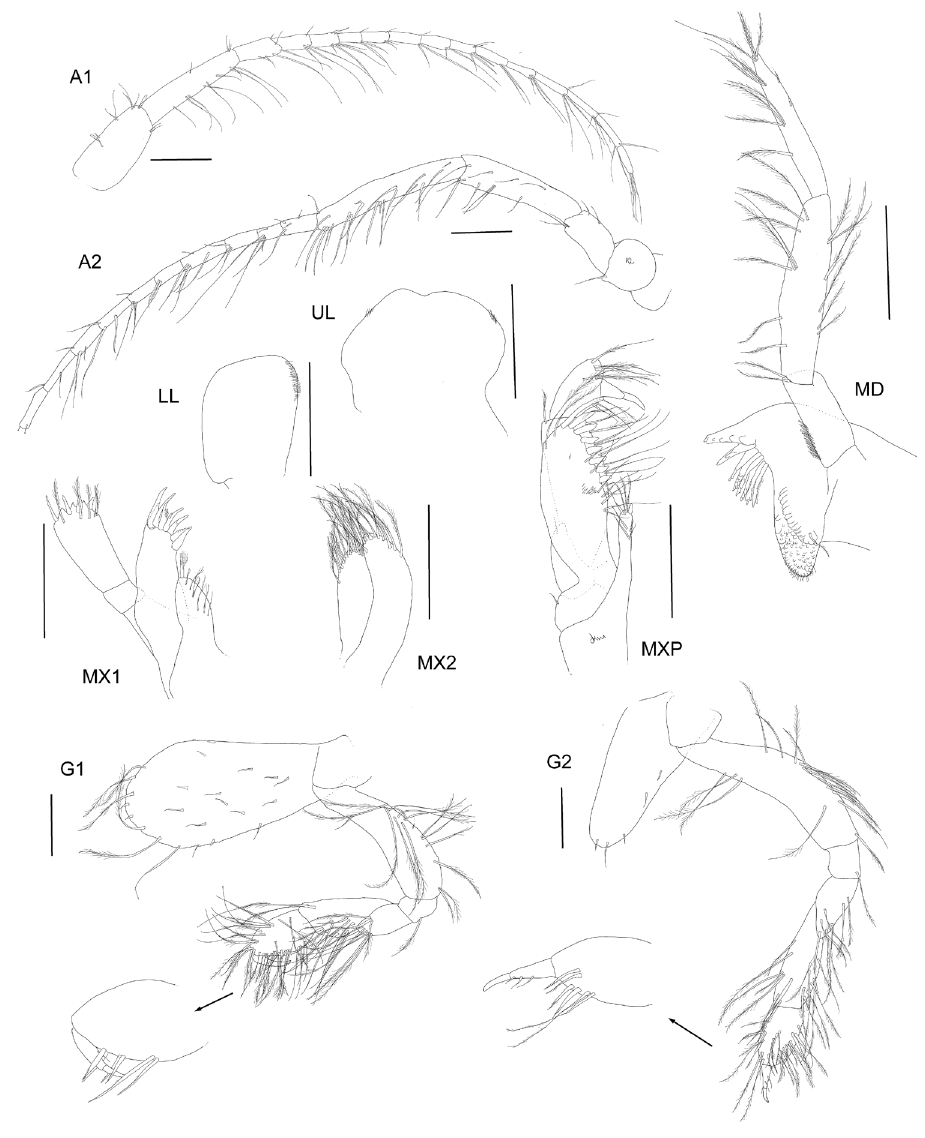
Figure 10. Haploops kaimmalkai sp. n. holotype, female, 6 mm, ZMH K-47057, Iceland Basin, 1384.8– 1389 m. Pereopods 3–7 scales represent 0.2 mm. Uropods 1–3 and Telson scales represent 0.1 mm. margin; dactylus long and curved, inner margin with only one seta, reaching over half of length of propodus. Gnathopod 2 coxa 2/3 length of coxa 1, narrowing distally, ventral margin rounded with sparse setae; basis longer than coxa, longer than car- pus and propodus combined, lateral margins with long plumose slender setae; merus non-lobate; carpus longer than merus and longer than propodus (1.6 ×),